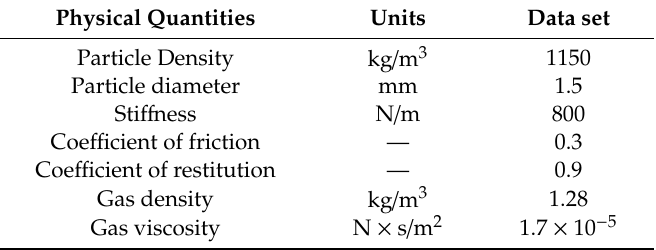
Table 2. Physical properties for the first simulation